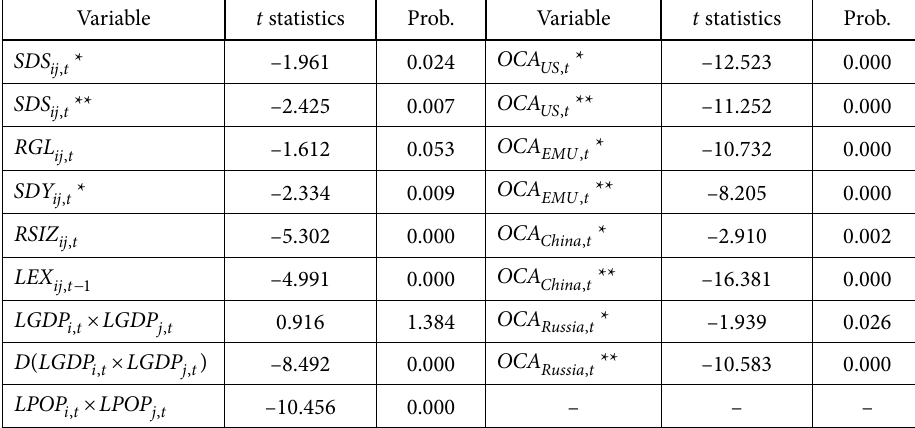
Table 1. Unit root test by LLC test (source: own research)